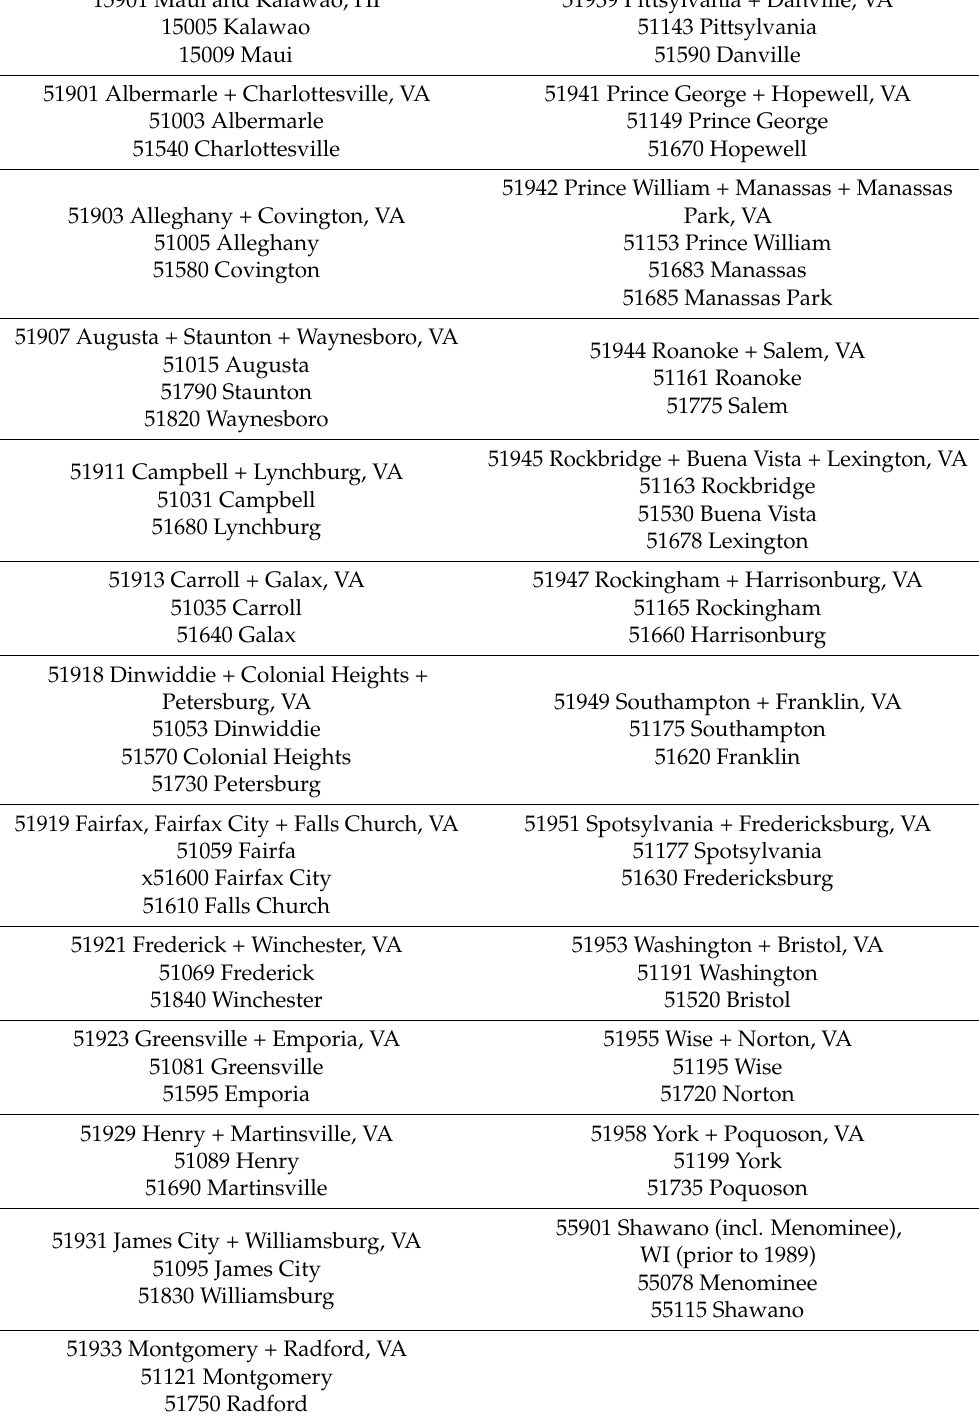
Table A1. BEA modifications to Federal Information Processing Standard (FIFS)